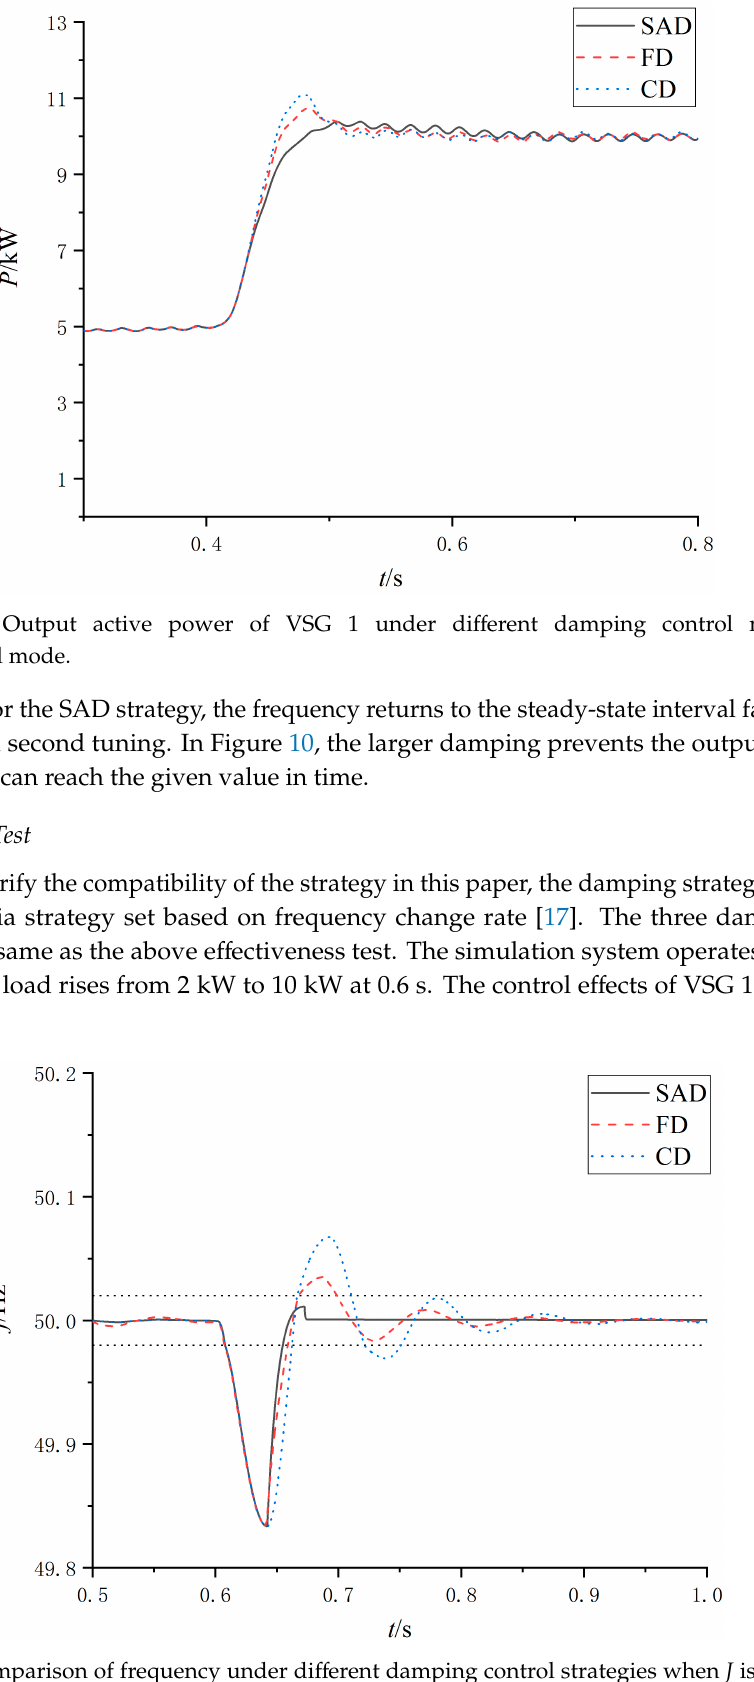
Figure 11. Comparison of frequency under di ff erent damping control strategies when J is based on frequency change rate.